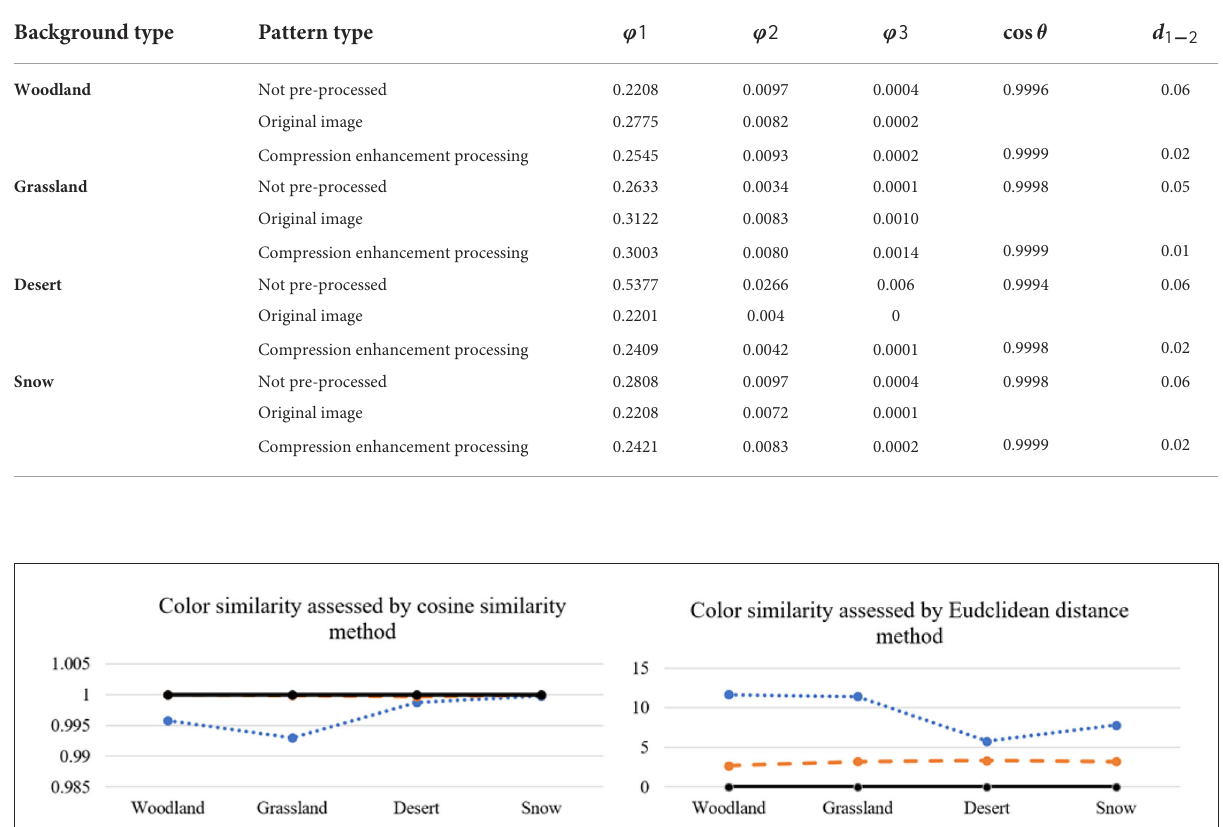
TABLE 5 Shape similarity of camouflage patterns.